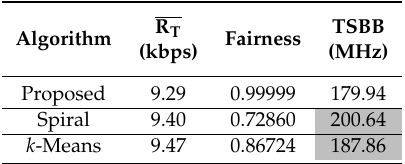
Table 4. Results of the different